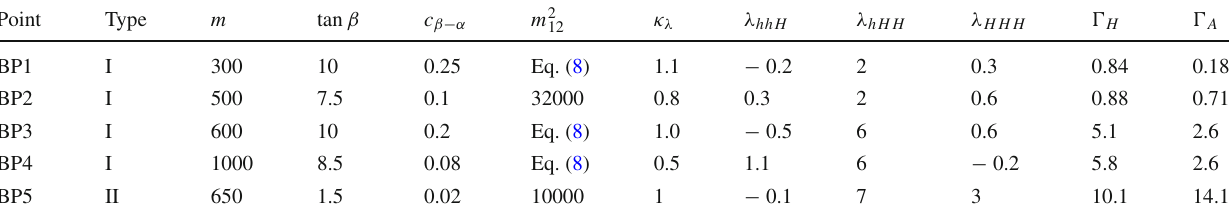
Fig. 17 Cross sections for e + e − → H H Z (left) and e + e − → H H ν ¯ ν (right) at The total allowed regions is given by the area inside the solid black line. The color code indicates the absolute cross section in fb Table 4 Benchmark points of the 2HDM selected for the study of the sensitivity to the triple Higgs couplings (masses and widths are given in